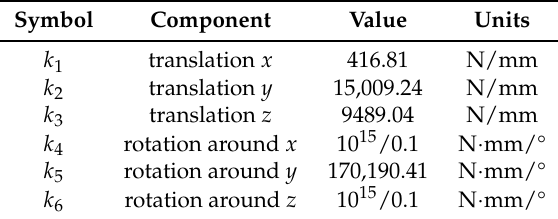
Table 2. Spring stiffness values used in the finite element model for each of the 6 degrees of freedom. Adapted from [26], Copyright (2019), with permission from Elsevier.